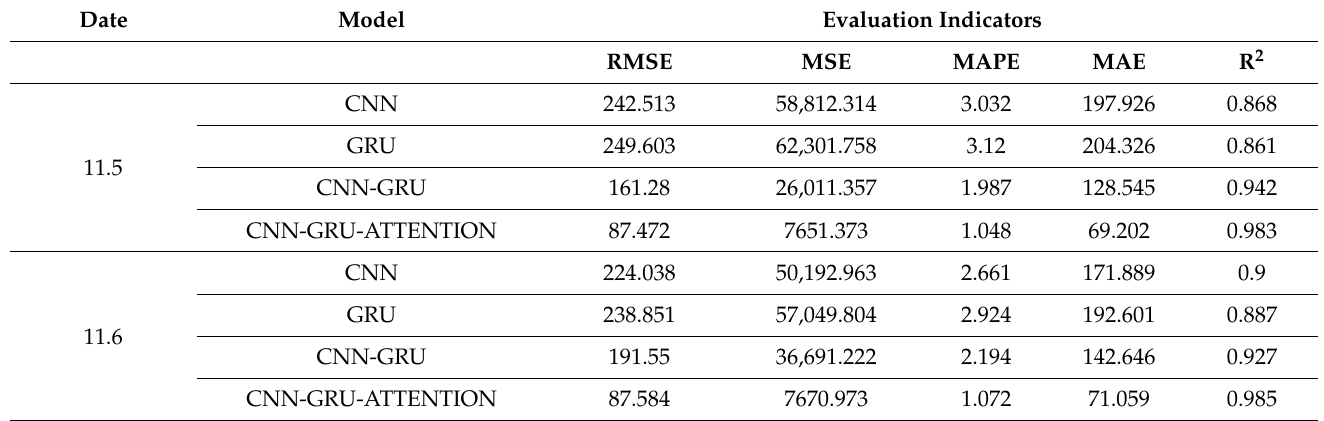
Table 4. Comparison of prediction accuracy for consecutive